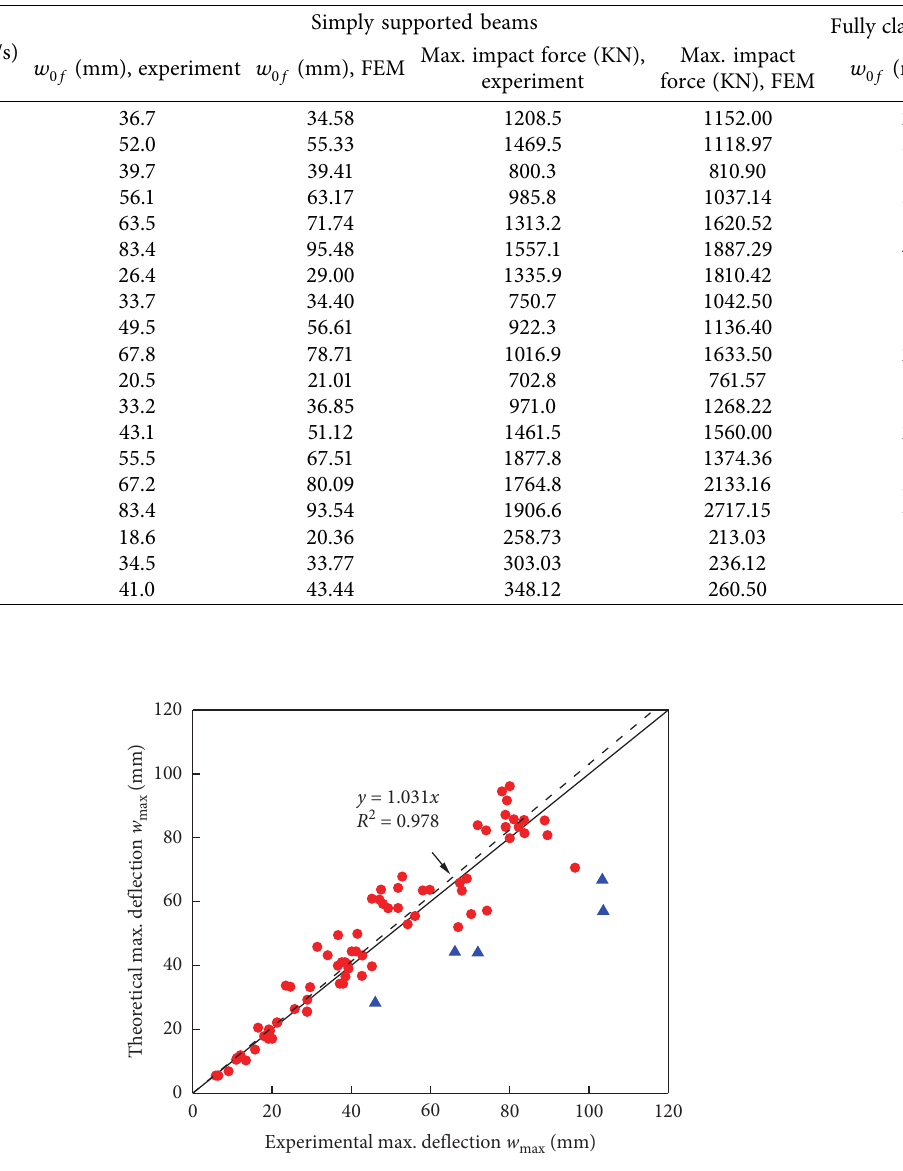
Figure 12: Comparison between the theoretical results and Kishi’s experiments for all series of simply supported RC beams. (a) Input energy-deflection curve for test series G3, G4, and G6. (b) Input energy-deflection curve for series G5 and